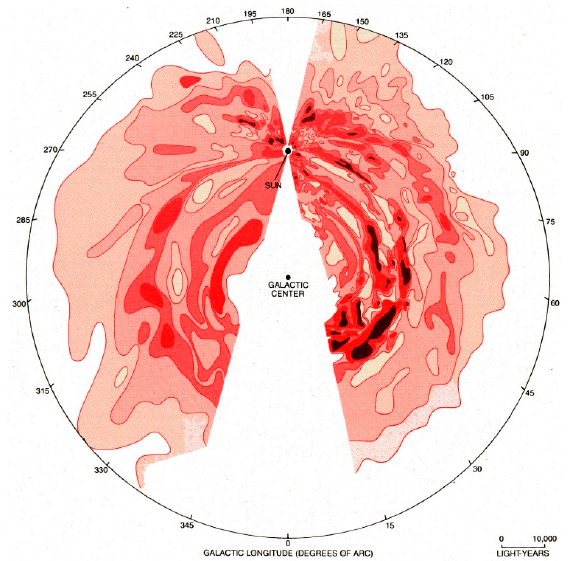
Figure 6. Early picture of the structure of the Milky Way based on a large number of radiotelescope observations carried out in the late 1950 s of the 21 cm radiowave emitted by hydrogen atoms (by electron spin flip). The picture combines observations carried out in the Netherlands and in Australia. At present, much wealthier observations are available, although the basic rationale and the results are the same. Whenever the Sun encounters some dense cloud of matter, a geomagnetic field reversal ( FR ) eventually occurs. The figure is borrowed after Gordon and Burton (1979) [11], and it has been used for the analysis of the correlation with the Hawaii volcanism during the last ~70 Ma . See text. The Sun has a magnetic shield, analogous to the Earth’s magnetosphere. The shield is called the heliosphere. A dense ICM can even compress the heliosphere (hence the solar wind) inside the Earth’s orbit. The associated violent e.m. induction inside a planetary object—originated by a temporary disappearance and reappearance of the solar wind—determines a violent generation of endogenous Joule heat. This is the explanation of the mysterious geomagnetic field reversals ( FR s) recorded on the Earth.